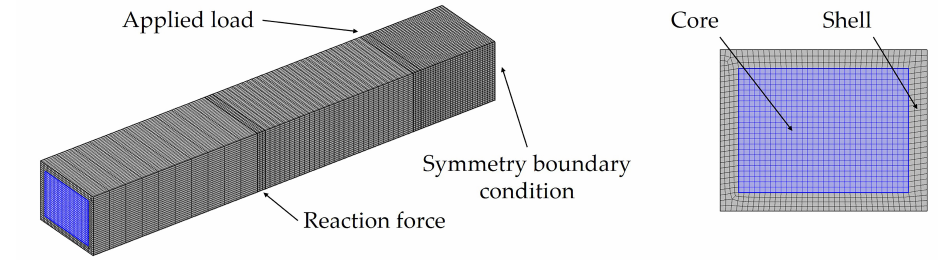
Figure 6. Quadrilateral Mesh for various surfaces of the symmetric FEA model.